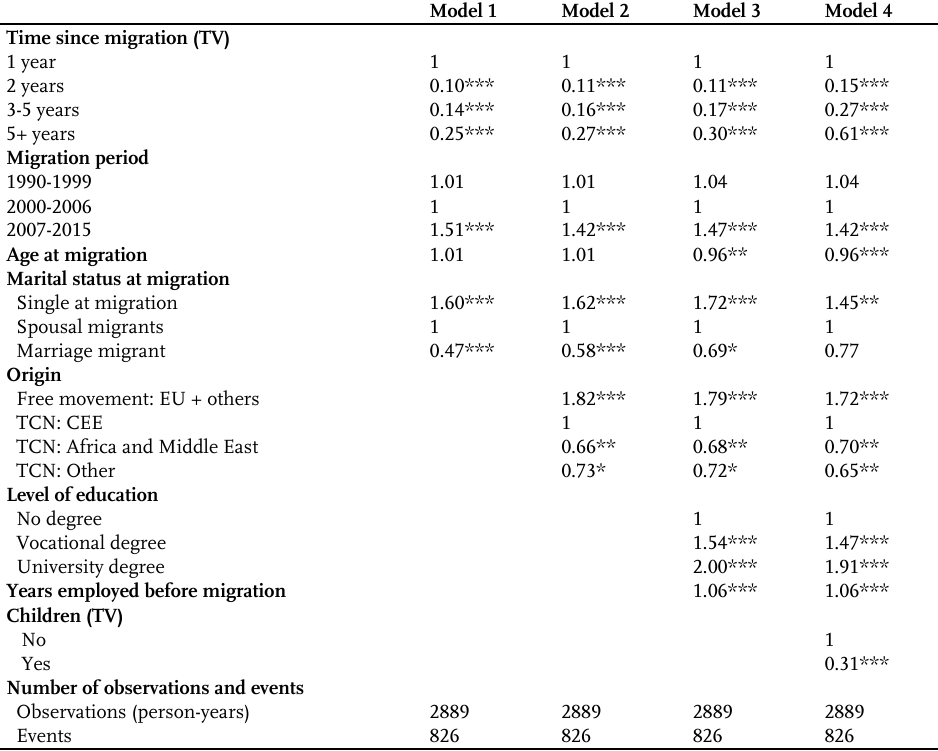
Table 3 : Results from complementary logit models: Relative risks of entry into first employment after migration, all childless women